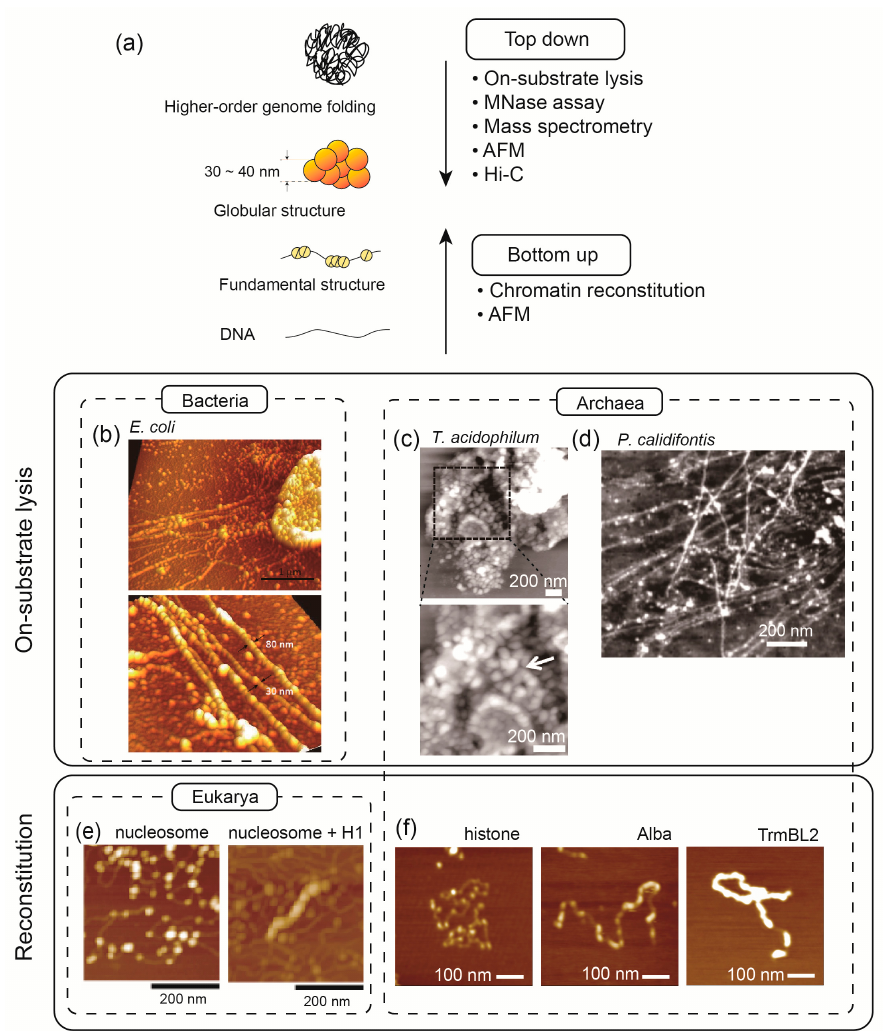
Figure 2. Methods for studying the structure of chromosomes. ( a ) The structural analyses of archaeal chromosome are shown as an example. Top-down approaches include on-substrate lysis, Micrococcal nuclease assay, mass spectrometry, AFM, and Hi-C, which are useful for identifying proteins responsible for higher-order genome folding as well as medium-scale chromosome folds such as 30–40 nm globular structure found in some archaea [31] and bacteria [15]. Bottom-up approaches include chromatin reconstitution in combination with AFM, are effective in identifying fundamental structural units and the factors required to fold them into higher-order structures. ( b – f ) Example AFM images taken in various approaches. On substrate lysis exhibits 30 and 80 nm nucleoid fiber from E. coli cell ( b ) [15], 30–40 nm globular structures from T. acidophilum cells (arrow) ( c ), and ~10 nm fibrous structure from P. calidifontis cells ( d ) [31]. ( e ) Reconstituted chromatin structure formed on DNA with eukaryotic histone octamer (left); a 30 nm fiber is formed with further addition of linker histone H1 (right) [32]. ( f ) Reconstituted archaeal chromosome structures formed with T. kodakarensis histone, Alba, and TrmBL2